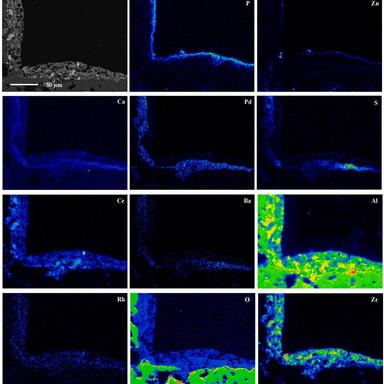
EPMA-WDS map data from the cross-section at the corner of C1.